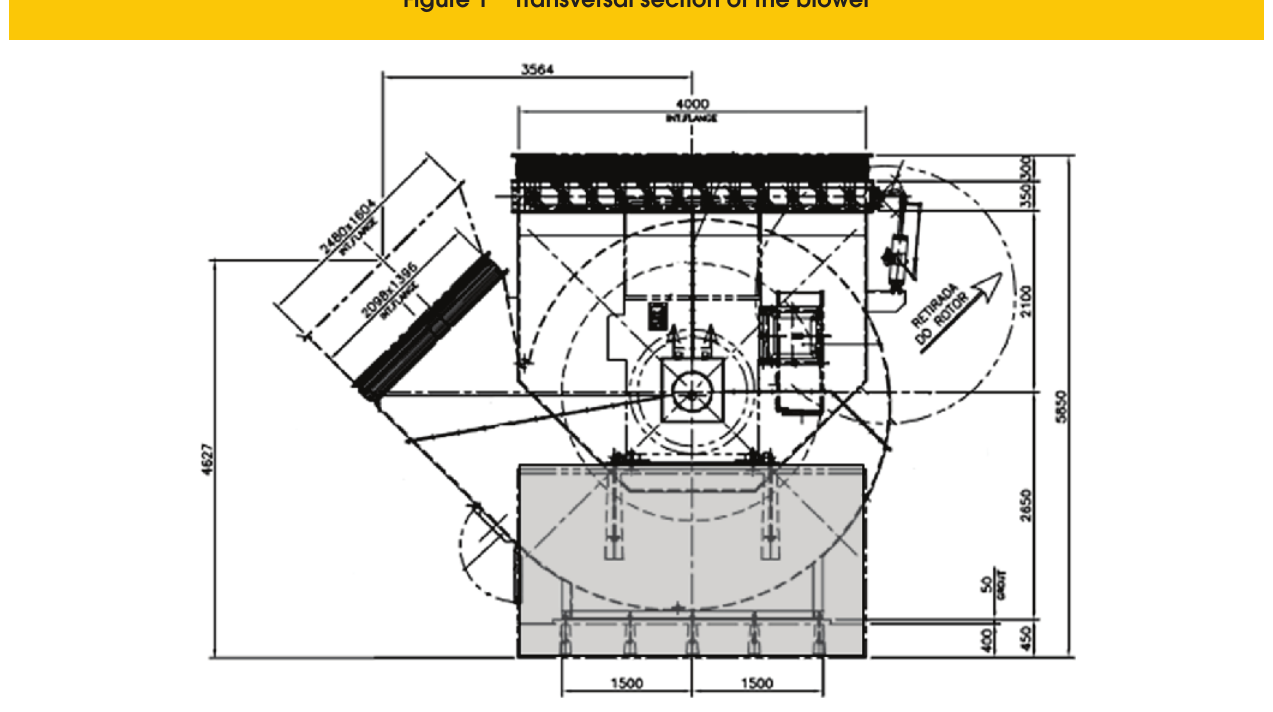
Figure 1 – Transversal section of the blower